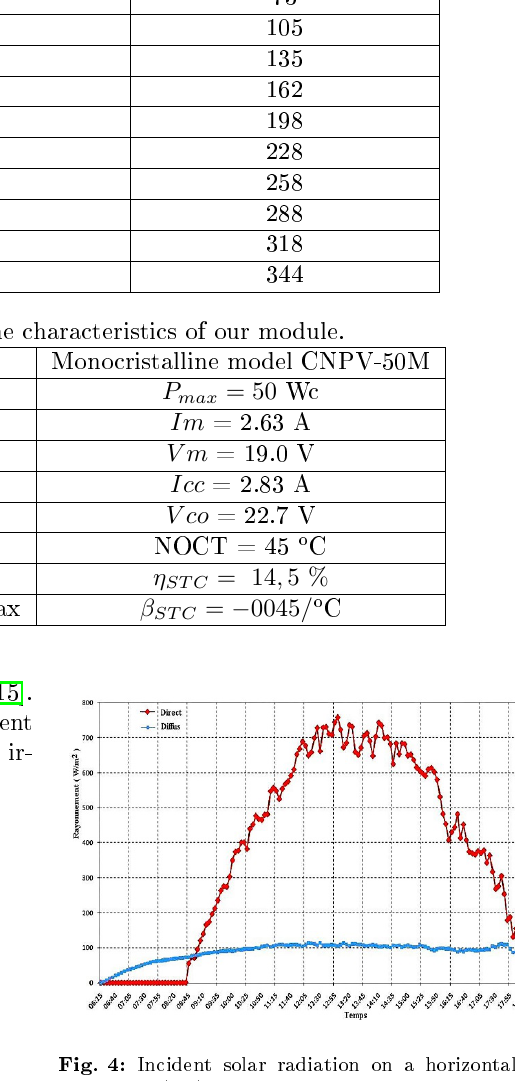
Fig. 4: Incident solar radiation on a horizontal plane 14/04/2007. direct and di(cid:27)use on a horizontal plane